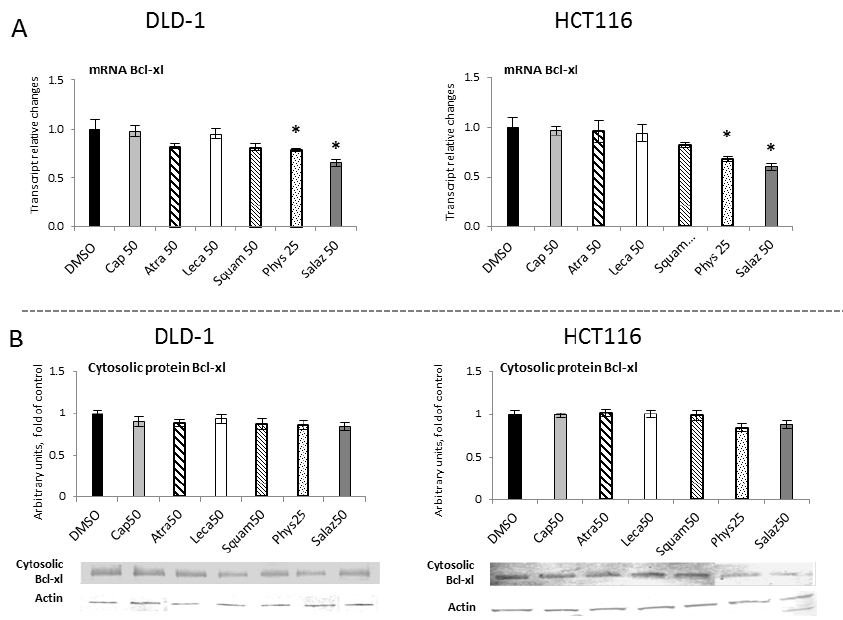
Figure 12. The effect of lichen-derived compounds on the expression of selected STAT3 target gene: Bcl-xl in DLD-1 and HCT116 cells. ( A ) Level of the Bcl-xl transcript. The values (fold of control) are presented as the means ± SEM from three separate experiments. ( B ) Level of the Bcl-xl protein. Representative Western immunoblots are presented under the graphs. Results (means ± SEM from three separate experiments) are presented as a fold change to control after normalization against the level of actin. Asterisks (*) denote statistically significant changes from the control group ( p ≤ 0.05). DMSO , vehicle control; Cap50 , caperatic acid (50 µ M); Atra50 , atranorin (50 µ M); Leca50 , lecanoric acid (50 µ M); Squam50 , squamatic acid (50 µ M); Phys25 , physodic acid (25 µ M); Salaz50 , salazinic acid (50 µM).